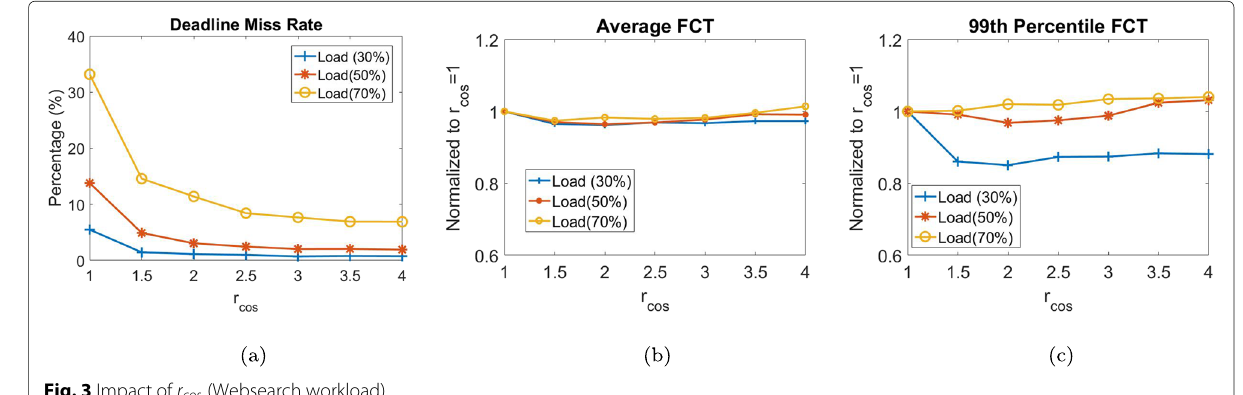
Fig. 3 Impact of r cos (Websearch